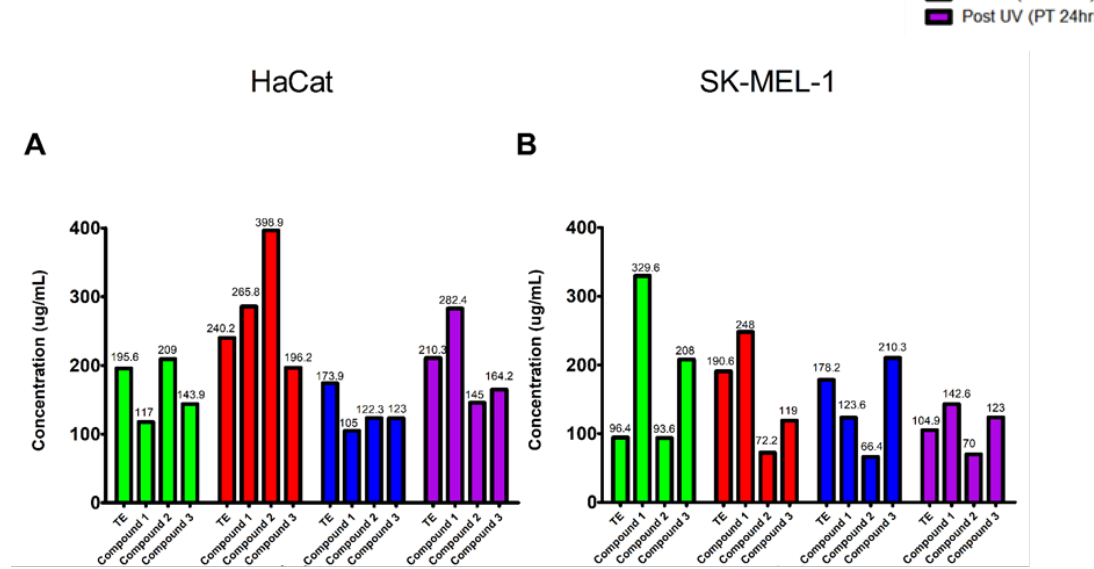
Figure 4. The IC 50 concentrations of the tested samples on the two cell lines, HaCaT ( A ) and SK-MEL-1 ( B ), after 4- and 24-h pre-exposure to determine cytoprotection against UVB.